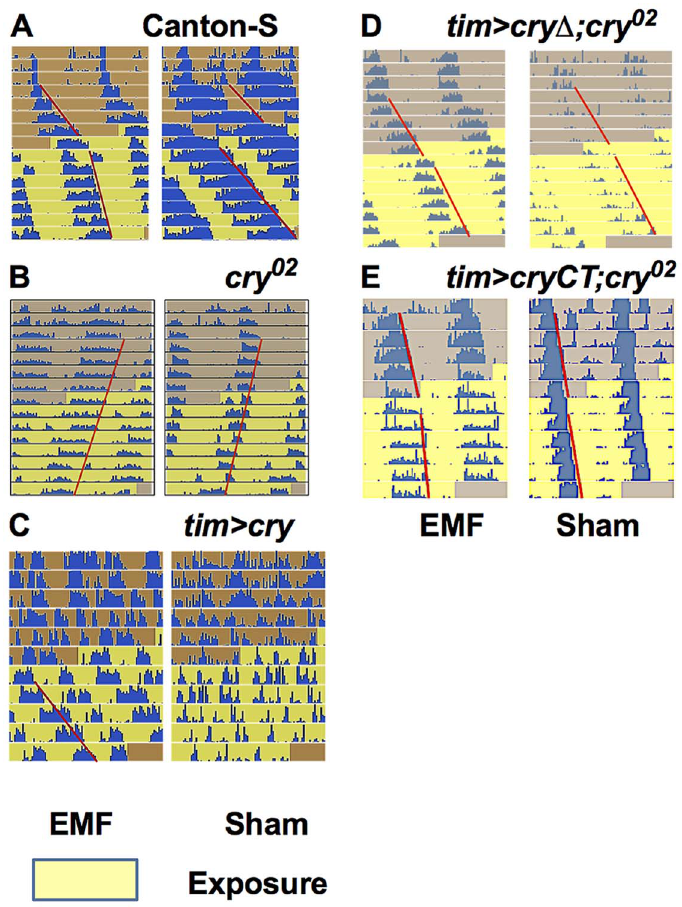
Figure 2. EMF exposure shortens circadian period. Representative free-running locomotor rhythms in dim blue, constant LL before and during the exposure to EMF (300 m T, 3 Hz). A. Exposed Canton-S flies showed a significant period shortening compared to sham. B. cry 02 flies did not show any EMF effect and maintain their free-run during the exposure period. C. Most exposed tim . cry flies showed arrhythmia before, but a well-defined period during the EMF exposure. D. tim . cry D ;cry 02 are not EMF sensitive. E. tim . cryCT;cry 02 show an EMF effect with a slight period shortening compared to sham exposed flies. Each horizontal line show activity events (blue) double plotted for two successive 24 hour periods, day 1 and 2 on the top line, day 2 and 3 on the second line and so on. The red line outlines the activity offset.